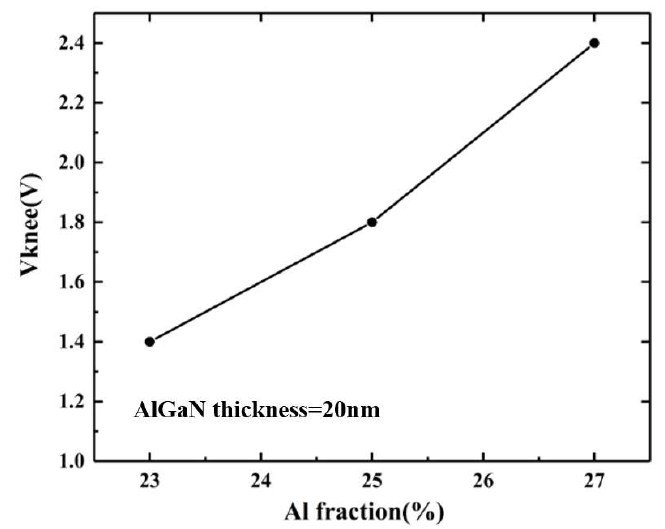
Figure 8. Variation curve of knee-point voltage of device with Al component of barrier layer.